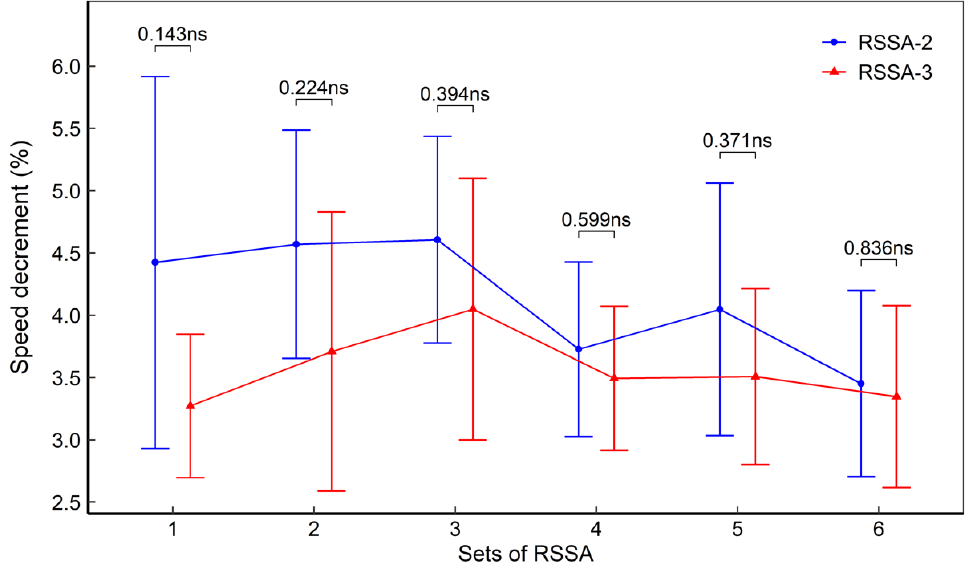
Figure 3. Speed decrement during RSSA-2 and RSSA-3 tests (ns—non-significant).